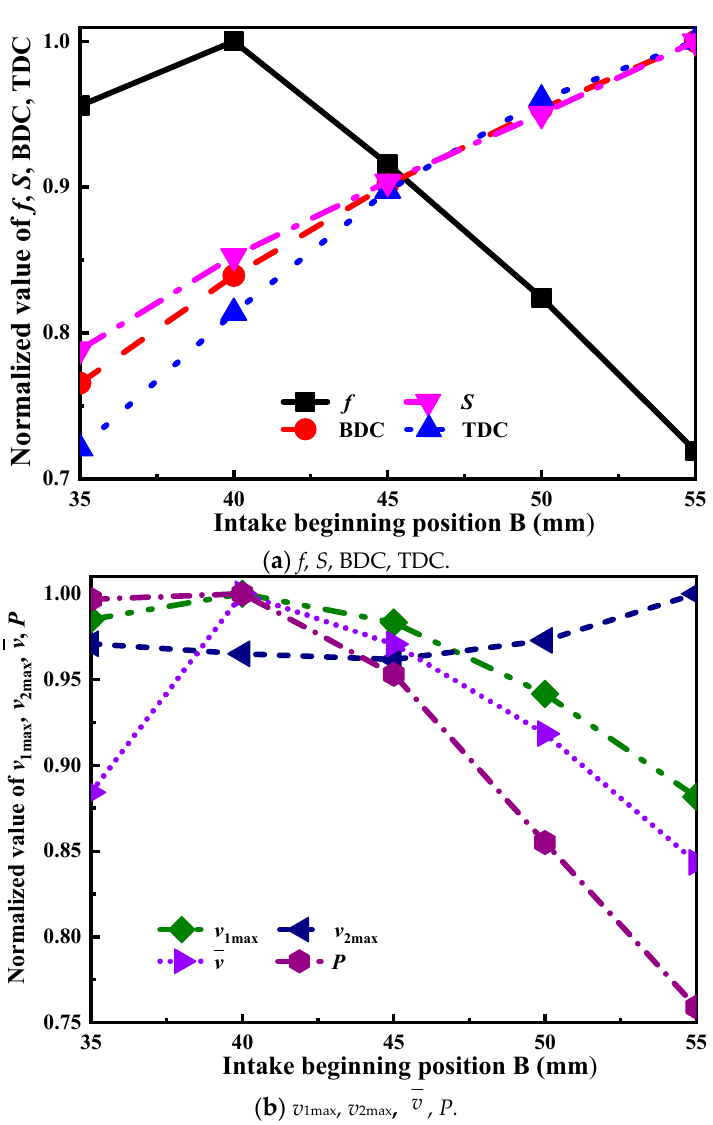
Figure 12. Variation of performance parameters with intake beginning position B.